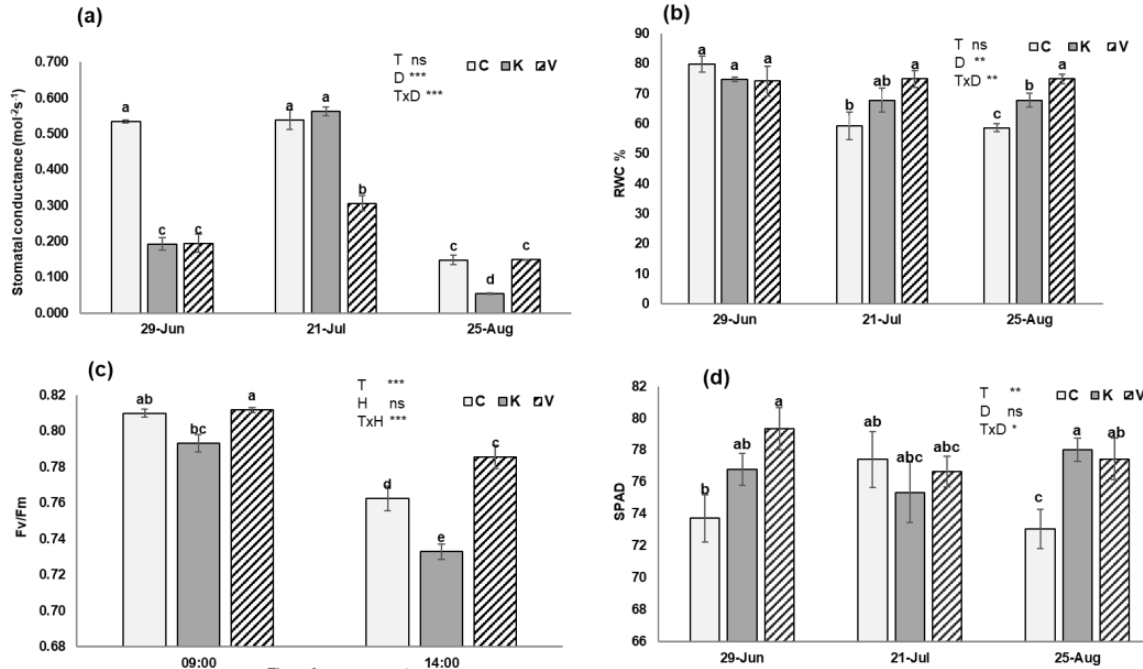
Figure 3. Effect of kaolin (K) and 1-p-menthene (V) after one (29-Jun), two (21-Jul) and three (25 Aug) months by the first application on: stomatal conductance ( a ), RWC (relative water content) ( b ), fluorescence (F v /F m ) measured at different temperature condition at 9:00 h and at 14:00 h ( c ). SPAD (soil plant development) index ( d ), versus C: control. Vertical bars indicate ± SE (standard error) of the means. Different letters indicate significant differences according to Duncan’s multiple-range test ( p = 0.05). Asterisks indicate significant effect of biostimulant treatment (T), days of measurements (D) and their interaction (T × D) according to two-way ANOVA (ns not-significant; * p < 0.05; ** p < 0.01; *** p < 0.001).